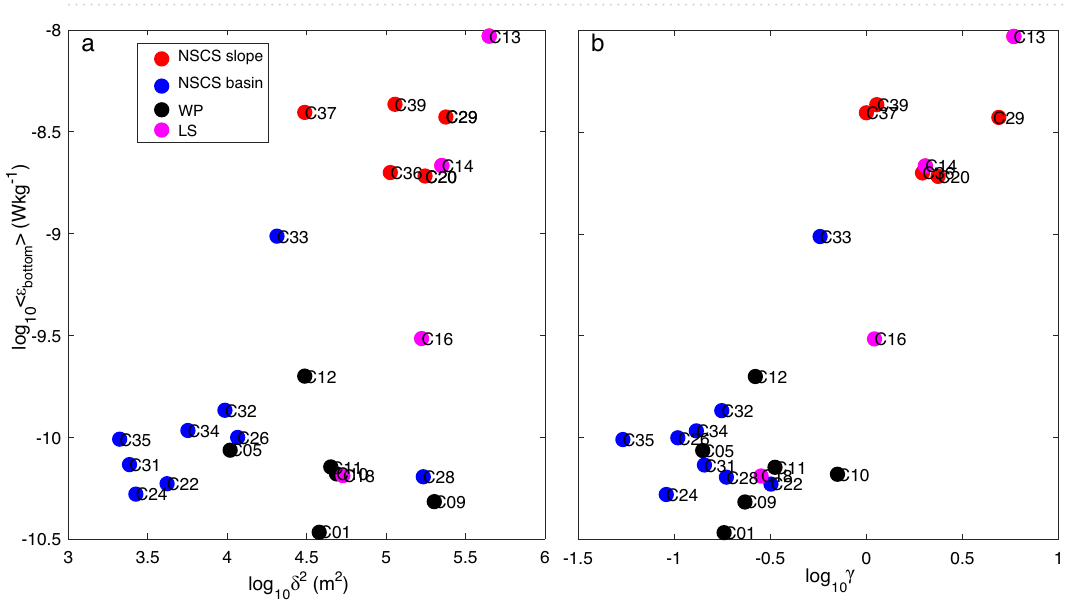
Figure 6. Average dissipation rate at the bottom layer (< ε bottom >) plotted against topography roughness ( δ 2 ) and slope criticality ( γ ) for semidiurnal tides. These symbols correspond to the station symbols in Fig.